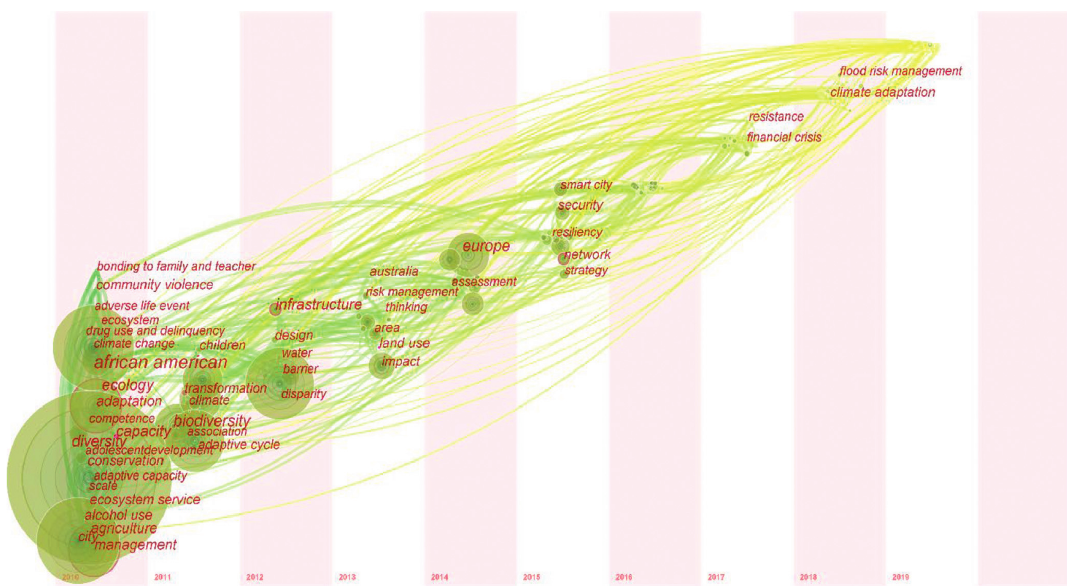
Figure 12: Visualization time zone map of keywords in resilient city research from 2010 to 2019.